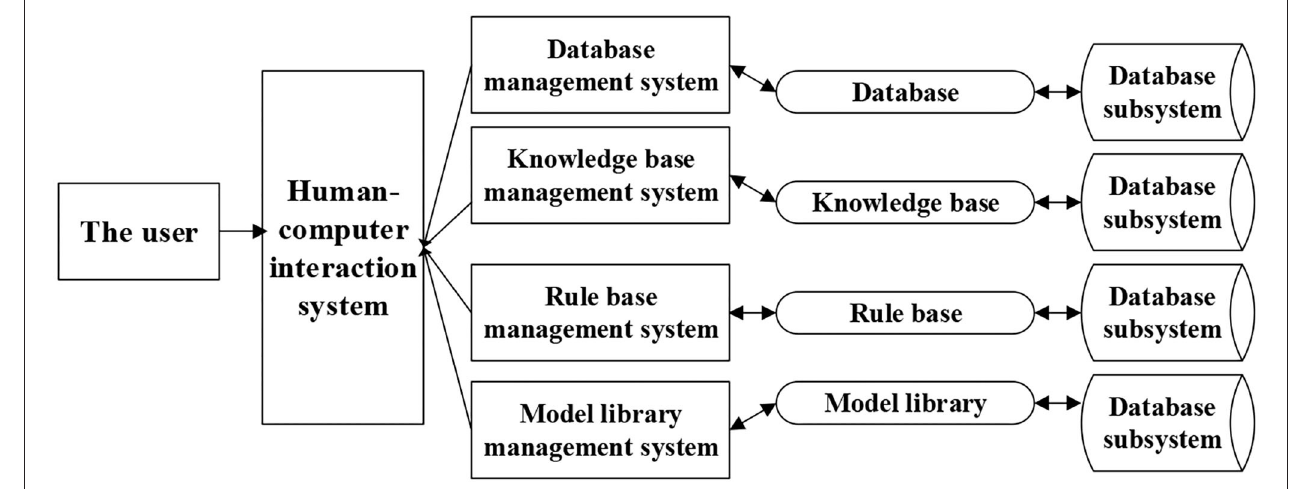
FIGURE 2 | The overall configuration of the smart exercise prescription system.